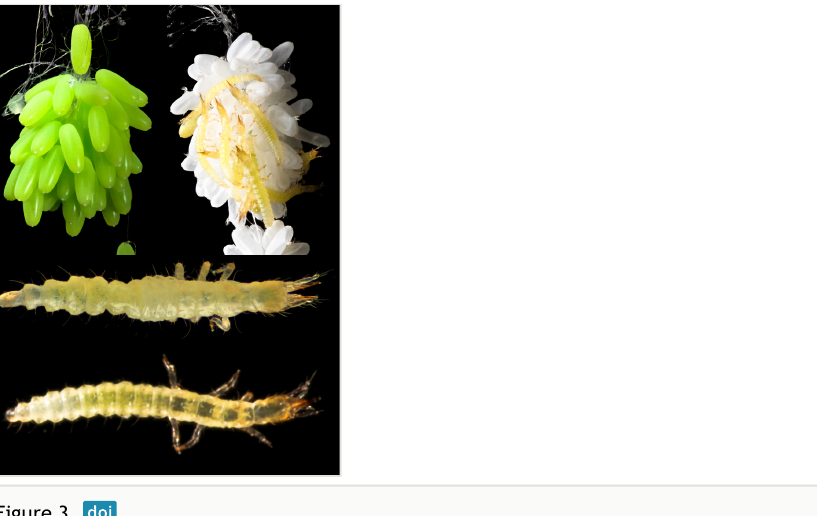
Figure 3. Ditaxis biseriata eggs and larvae. Top Left. Egg batch before eclosion; Top Right: egg cluster after eclosion of fi rst instars, seen clustered on the egg batch; Middle: dorsal view of preserved fi rst instar; Bottom: dorsal view of live fi rst instar during